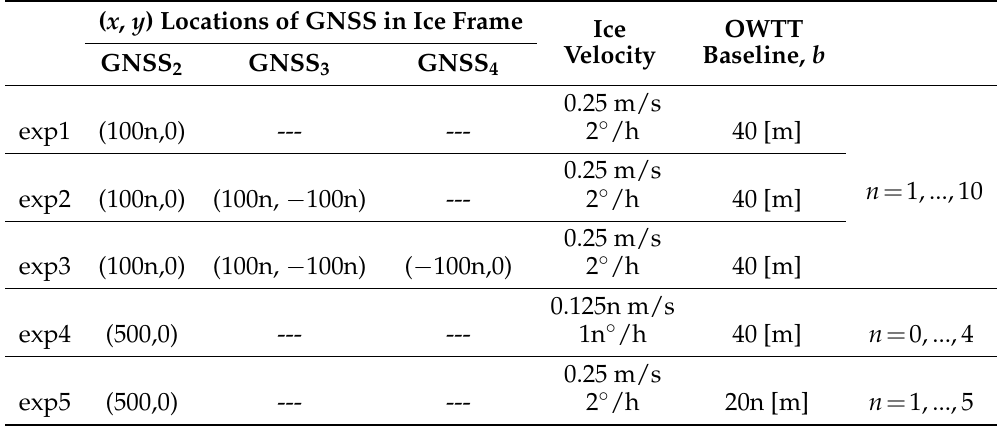
Figure 1. The world, ice, ship, and vehicle coordinate frames are shown in ( a ). Global navigation satellite system (GNSS) beacons are simulated in line, triangle, and square configurations as seen in ( a – c ), with separation varying 100–1000 m. Experiments 1–3 correspond to GNSS configurations in ( a – c ) with varying spacing, under constant ice velocity and One Way Travel Time (OWTT) transducer spacing. Experiment 4 assumes a GNSS line configuration, fixed OWTT spacing, and varying linear and angular ice velocities. Experiment 4 assumes a GNSS line configuration, fixed ice velocity, and varying OWTT spacing. Simulation parameters are summarized in Table 3. Table 3. Parameters under variation in the sensitivity analysis included number (and spacing) of ice-deployed GNSS units, ice velocity, and OWTT transducer